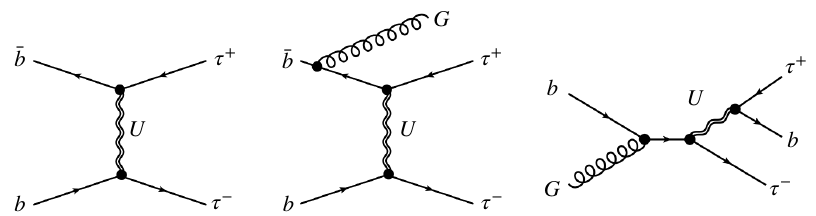
Figure 1 . Examples of singlet vector LQ contributions to the DY ditau spectrum initiated by bottom- quark fusion. The left Feynman diagram describes the tree-level process involving t -channel singlet vector LQ exchange ( U ), while the middle (right) graph represents the real gluon ( G ) corrections with non-resonant (resonant) intermediate U . See main text for further details.